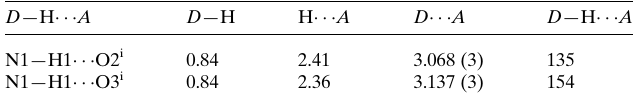
Table 1 Hydrogen-bond geometry (A˚ , (cid:2) ).